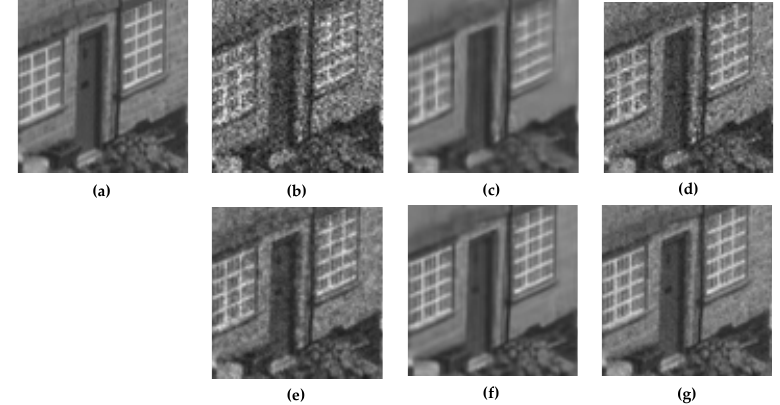
Table 2. The quantitative results of different methods on synthetic SAR images (PSNR-SSIM). Noisy Image Number (4-Looks) Figure 4. Filtering results of the image “Hill” corrupted by simulated speckle (first scene with changing and 1-Look noise): ( a ) Reference image (noise-free); ( b ) Noisy with single-look; ( c ) FANS; ( d ) CDMF; ( e ) QF; ( f ) MSAR_BM3D; ( g ) Proposed.